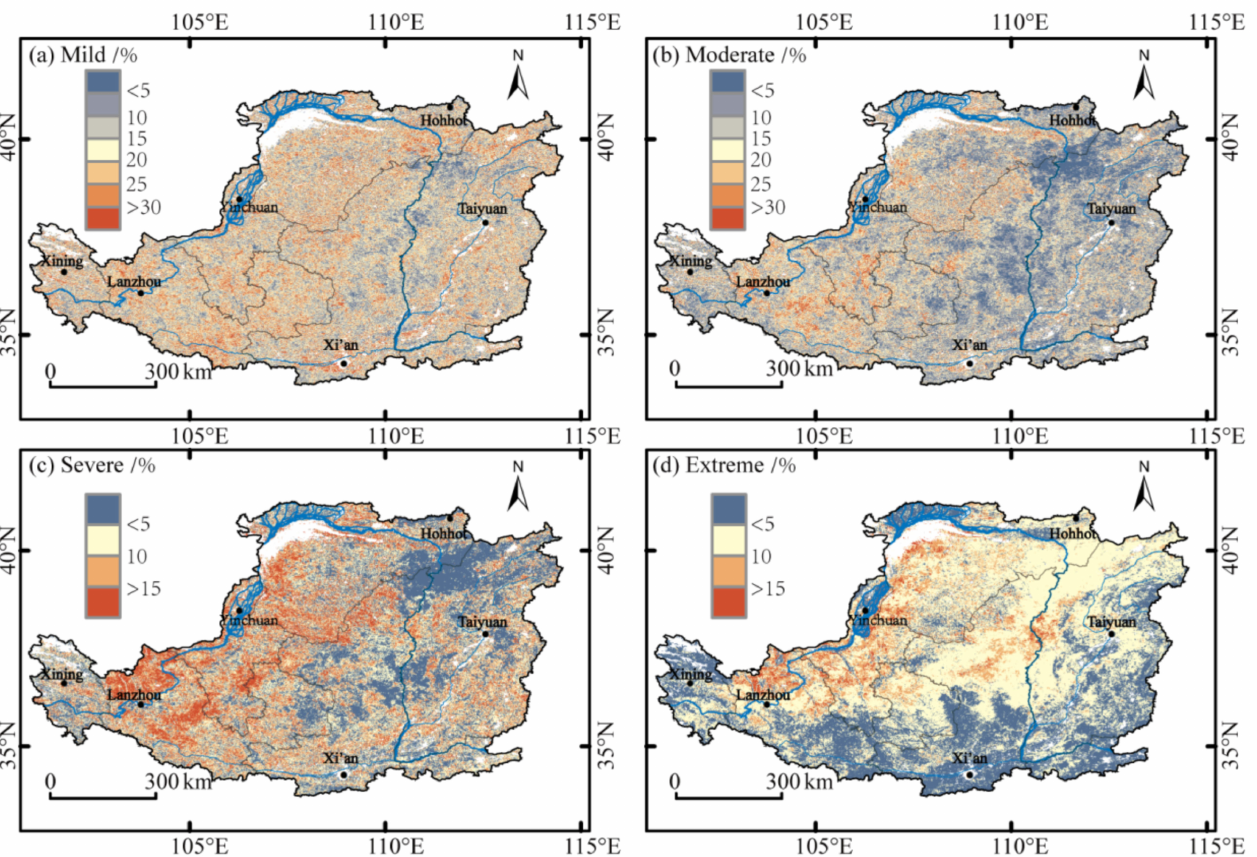
Figure 4. Spatial pattern of drought frequencies for various drought grades during the vegetation growing period according to WVCI values across the Loess Plateau. ( a ) Occurrence frequency of mild drought; ( b ) occurrence frequency of moderate drought; ( c ) occurrence frequency of severe drought; ( d ) occurrence frequency of extreme